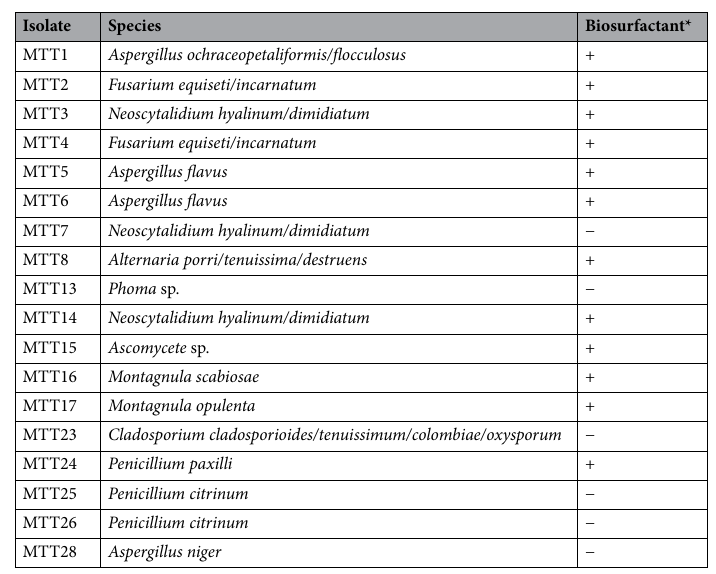
Table 3. Biosurfactant activity of the selected isolates. *Biosurfactant detection: (+) biosurfactant produced; (−) no biosurfactant